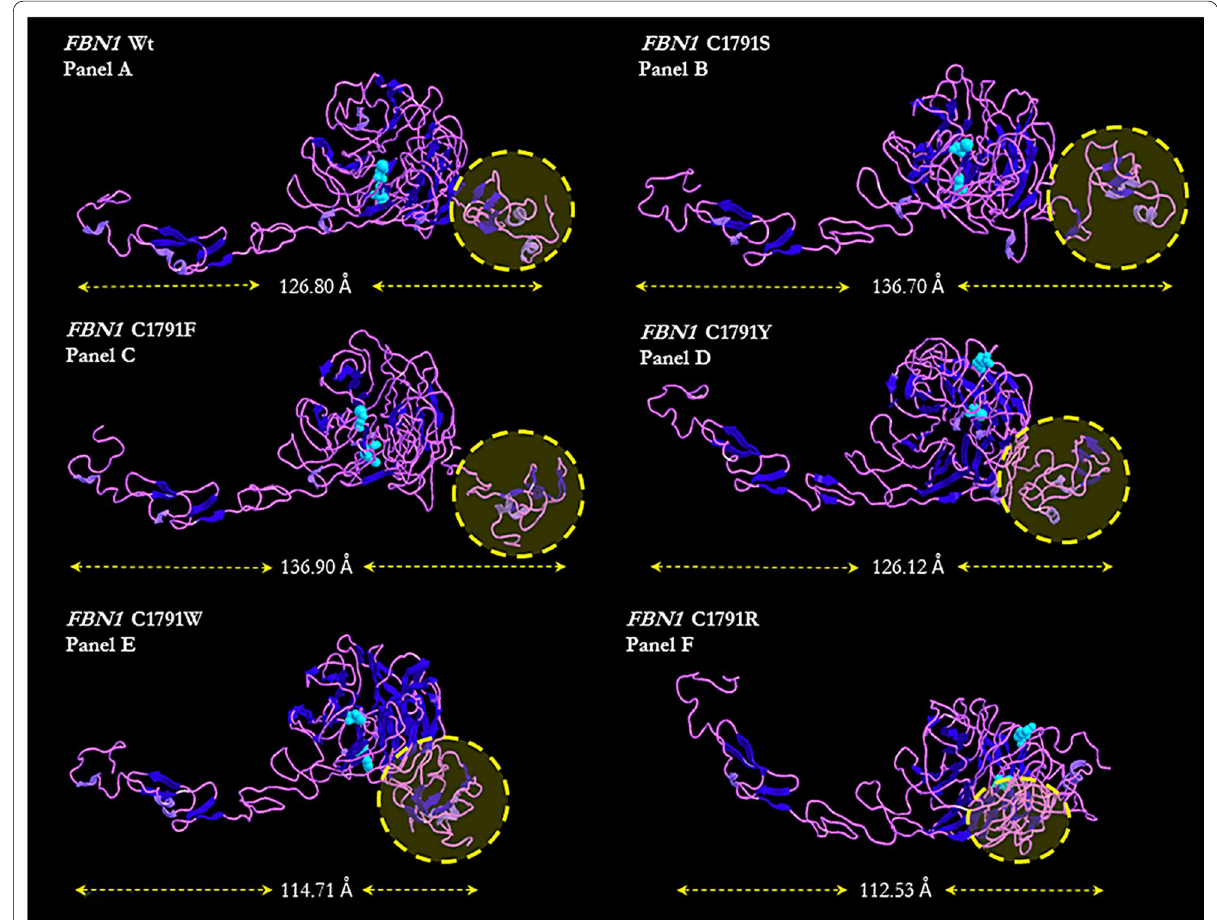
Fig. 3 The structure of the missense pathogenic variant in the amino acid sequence between the TB7 and TB8 domains was analyzed (AA 1500– 2119). The variant p.Cys1791Ser found in the EGF-like domains 29 interferes with the formation of a disulfide bond between the two cysteines. (Residues 1777 and 1791 were highlighted in blue space filling mode.) The new pathogenic variant p.Cys1791Ser (panel B) causes an 8 per cent lengthening of the region between the TB6 and TB8 domains. The total length of the analyzed amino acid fragment changes from 126.80 Å in the wild-type protein to 136.70 Å in the mutant protein. The effect of the new variant is comparable to that of the variant p.Cys1791Phe (panel C), which causes an elongation of the analyzed region. The amino acidic changes to Thr and Arg (panels E and F) appear to be the least tolerated. These two pathogenic variants caused TB8 module misfolding with a rotation of about 90°, as indicated by the yellow circle. The final variant, p.Cys1791Tyr (panel D), appears to have no effect on protein length while causing a critical misfolding of the EGF-like 29